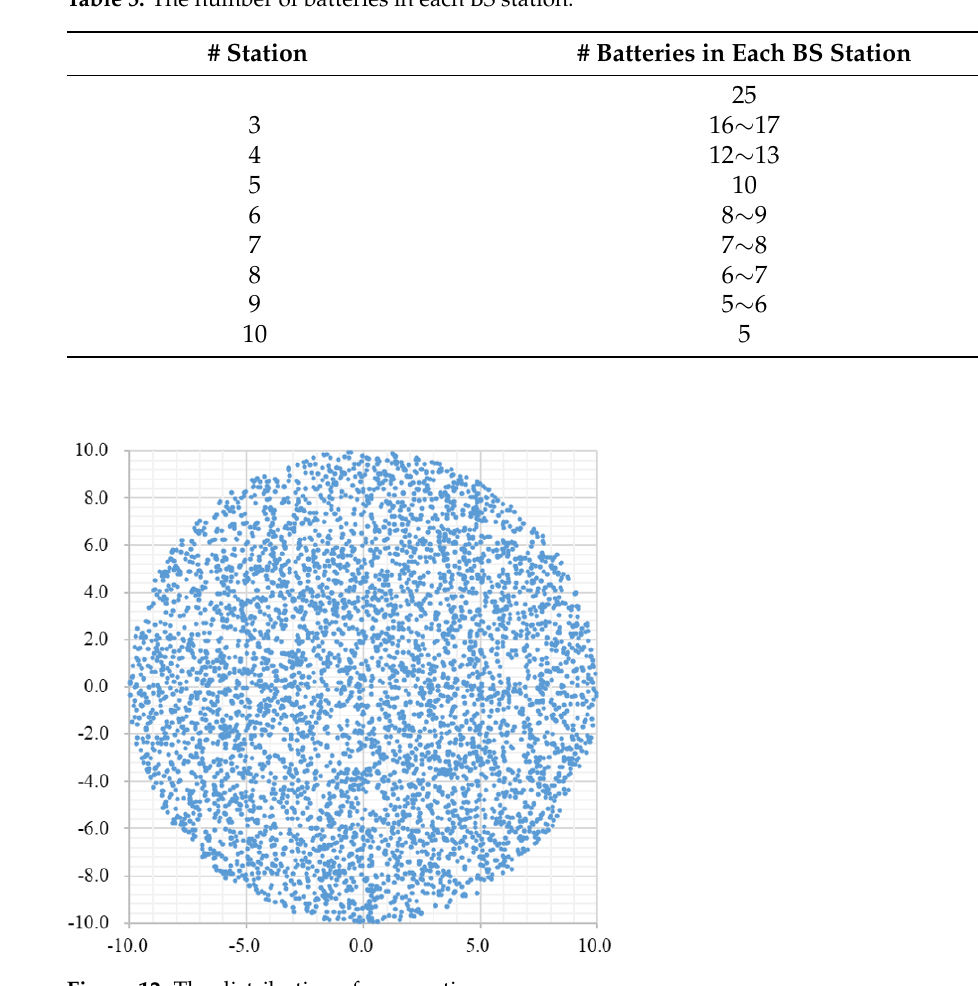
Figure 12. The distribution of prospective